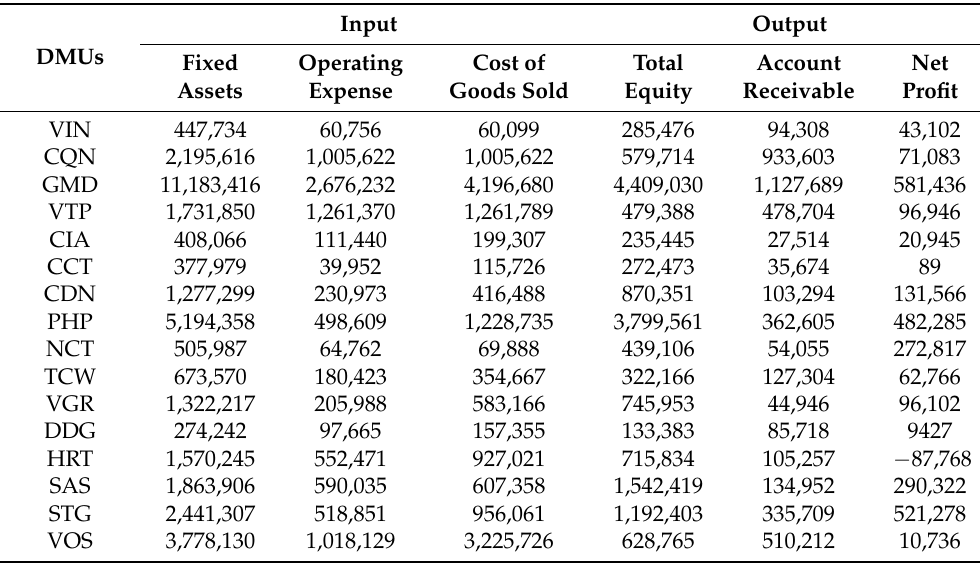
Table 3. The data of Vietnam logistics company 2019 (Unit: million